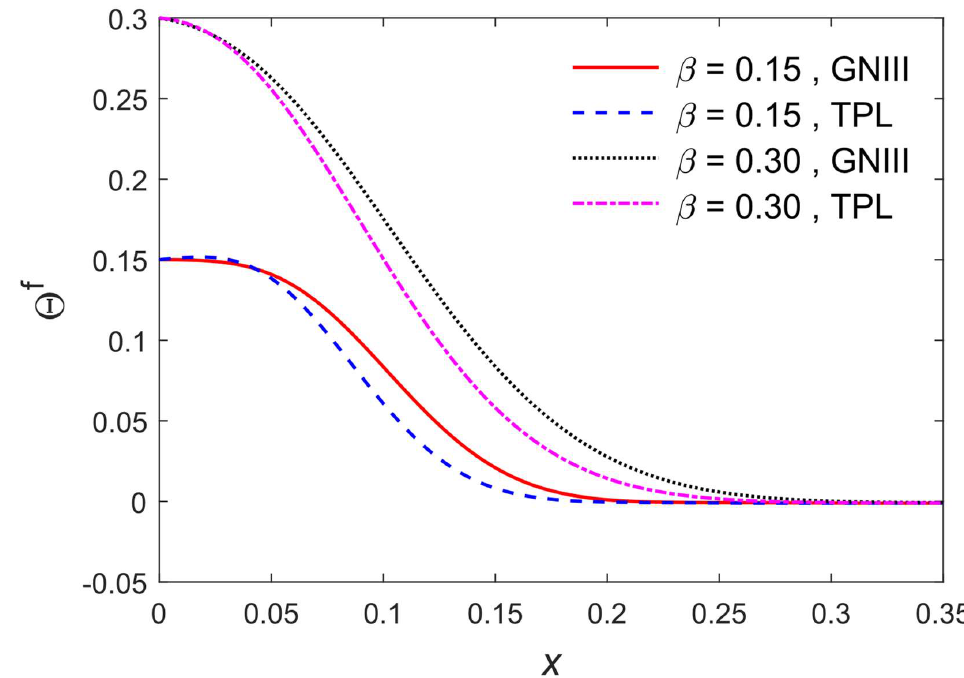
Figure 5. The distributions of fluid temperature Θ f along the distance x .